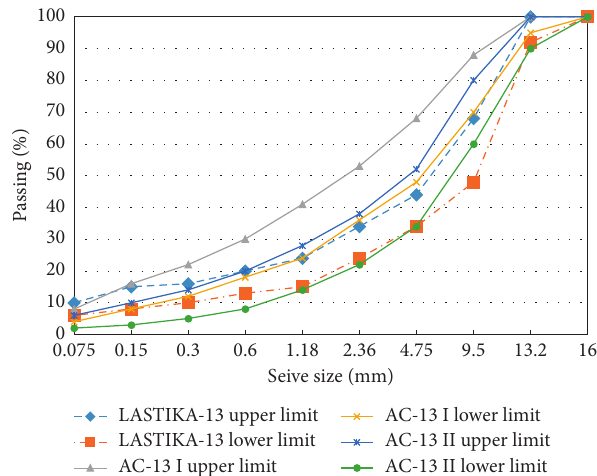
Figure 2: Three gradations of asphalt mixtures used in this